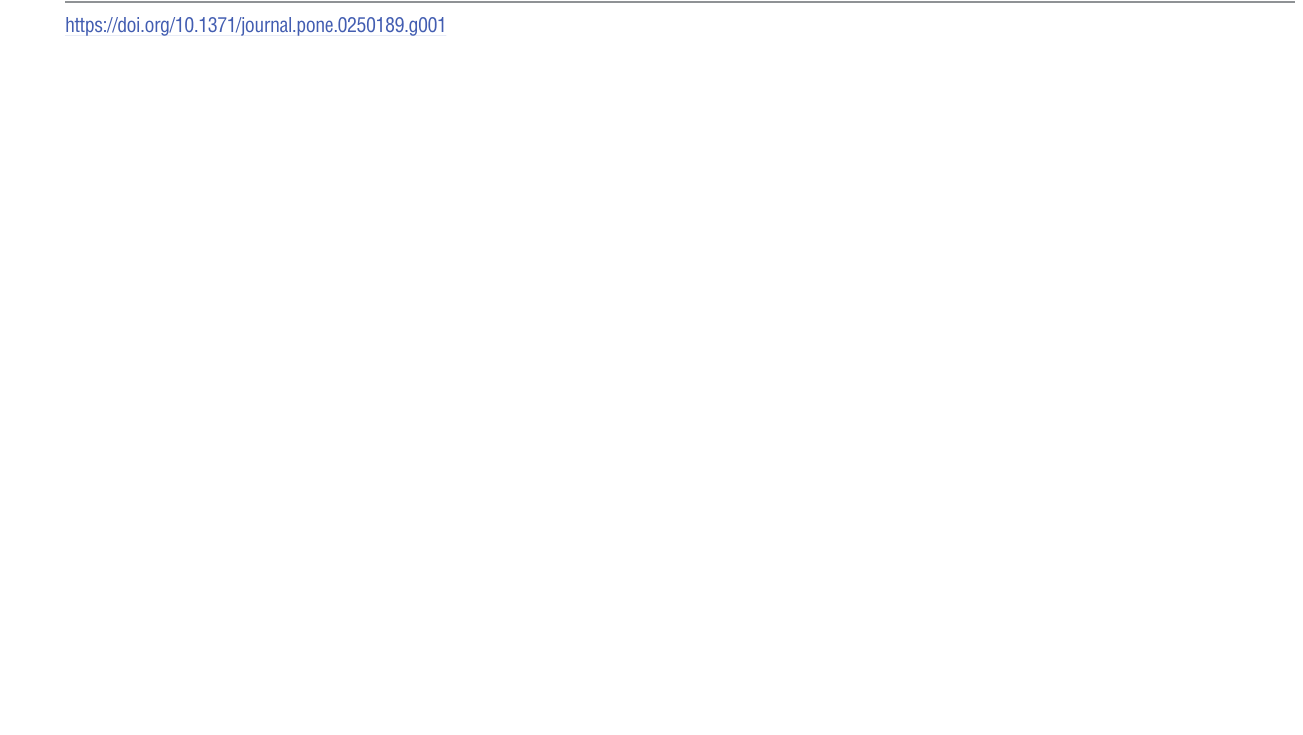
PLOS ONE | https://doi.org/10.1371/journal.pone.0250189 April 8, 2021 2 /